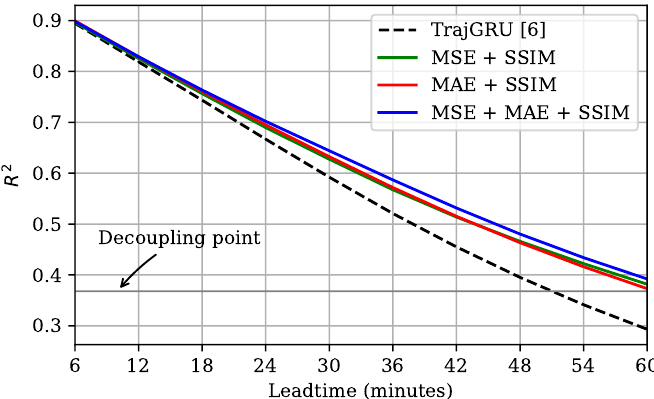
Figure 10. Coefficients of determination over lead times. Value of the decoupling point is 1/ e . Best view in